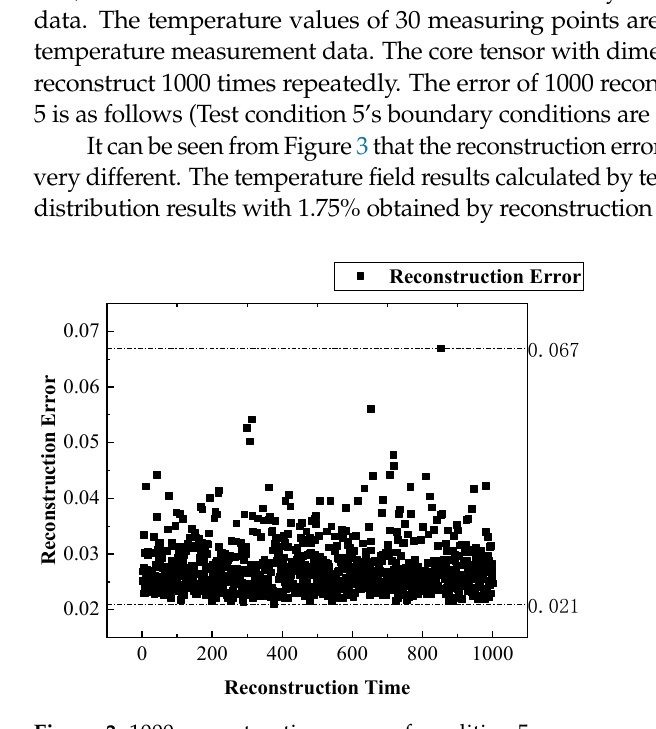
Figure 4. Bimodal temperature distribution model in the computational domain: ( a ) calculation re ‐ sults; ( b ) reconstruction results. As shown in Figure 4, the reconstruction result after preliminary selection can recon ‐ struct the temperature field well, but this result is one of the smaller relative errors se ‐ lected from the 1000 reconstructions with the different arrangements of measuring points. In order to ensure the high ‐ precision reconstruction of the temperature field, it is neces ‐ sary to further improve the accuracy on the basis of the first reconstruction calculation and to determine the number and location of the measuring points. In order to analyze the adaptability of the reconstruction algorithm to different oper ‐ ating conditions, five different operating conditions were calculated with other conditions being equal. Reconstruction error is shown in Figure 5. Y （ m ） X （ m ）